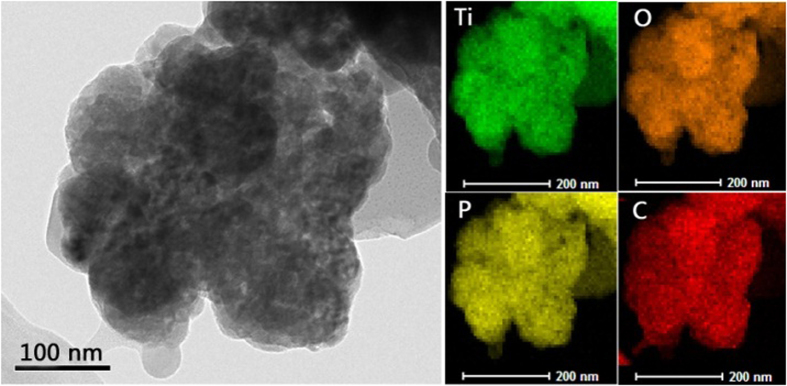
STEM-EDS elemental mapping images of as-prepared mesoporous
LiTi2(PO4)3@C
composite.